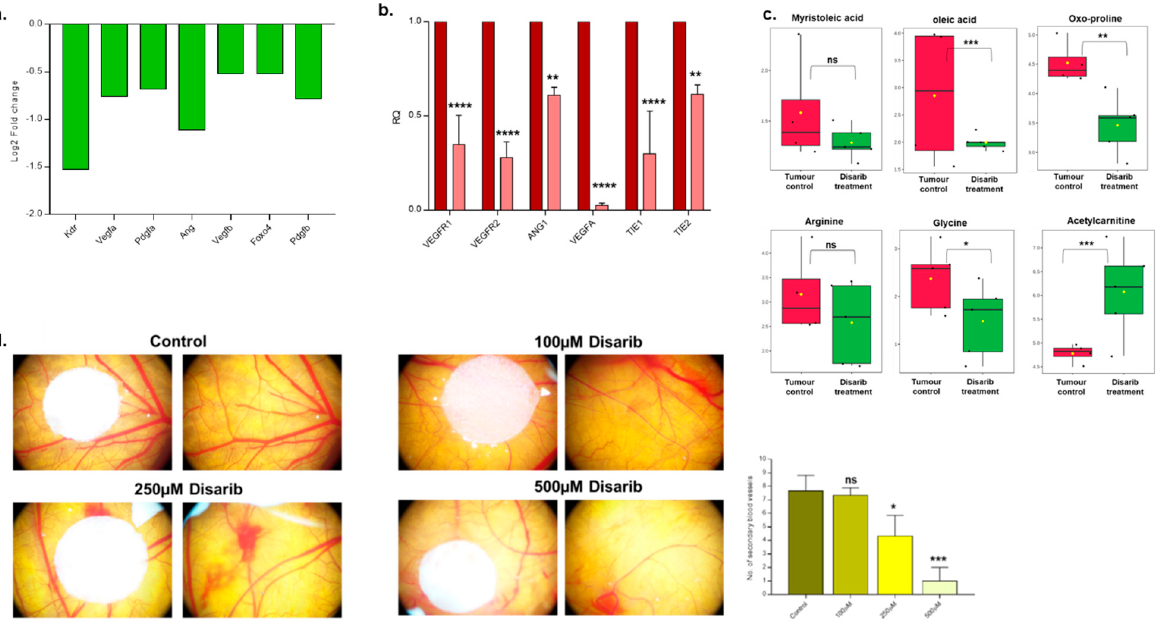
Figure 7. Anti-angiogenic effects of Disarib. ( a ) Line graph depicting expression of angiogenic markers in Disarib-treated EAC tumour model from RNAseq data. The x -axis represents genes, and the y -axis represents log2Foldchange. ( b ) Grouped bar graph showing expression of angiogenic markers in Disarib-treated EAC tumour model from qRTPCR. The maroon bar represents tumour control, and the pink bar represents Disarib-treated samples. The x -axis represents genes, and the y -axis represents relative quantification. ( c ) Individual box plots depict fold change of metabolites participating in angiogenesis. Red colour denotes tumour control, and green colour denotes Disarib-treated samples. ( d ) Anti-angiogenic effects of Disarib. Representative images of CAM assay. There are four panels: control, 100 µM, 250 µM and 500 µM Disarib (with and without the disc) and a bar graph showing the number of secondary blood vessels. The graph shows mean # SEM (ns: not significant, * p < 0.05, ** p < 0.005, *** p < 0.0001, **** p < 0.00001).